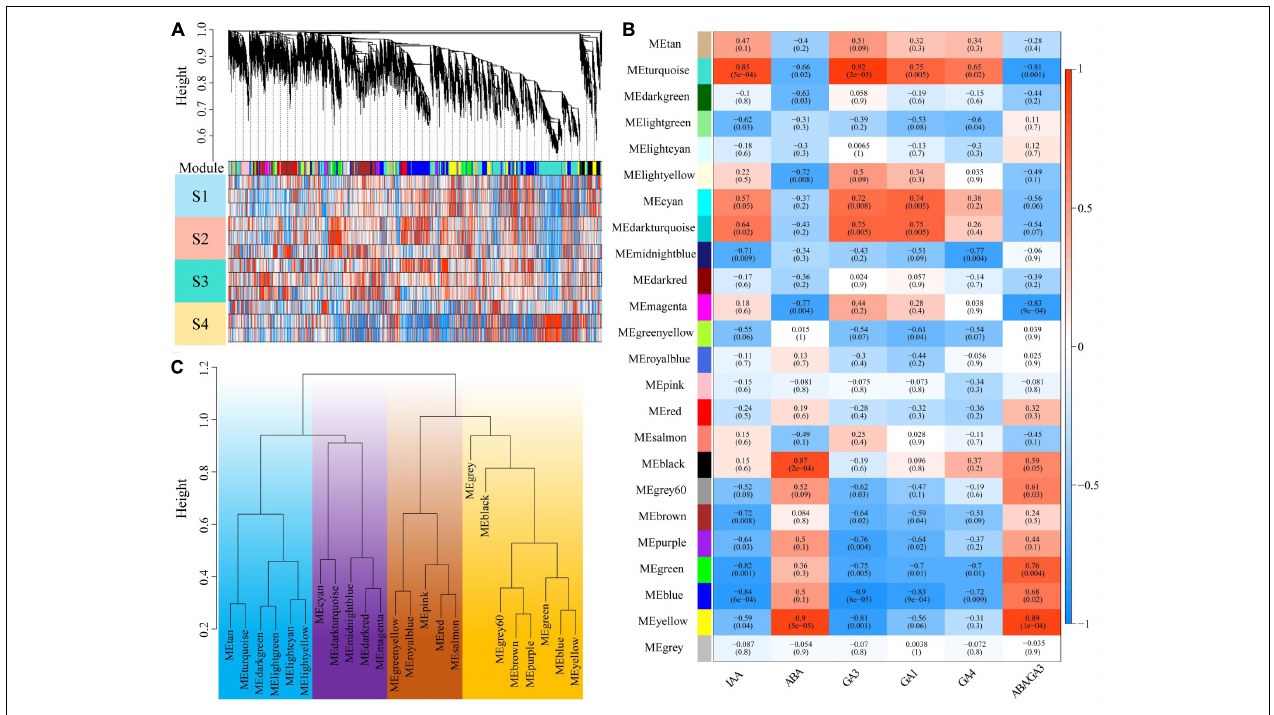
FIGURE 1 | Identification of key modules correlated with plant hormone content in the RNA-seq dataset through weighted gene co-expression network analysis. (A) The gene dendrogram and the corresponding module colors. The clustering was based on the RNA-seq data in four stages of dormancy. (B) A heat map showing the relationship between the modules and plant hormones. The corresponding correlation and p -value were presented in the first line and second line of each cell, respectively. (C) Clustering of module eigengenes. Clustering was distinguished by different